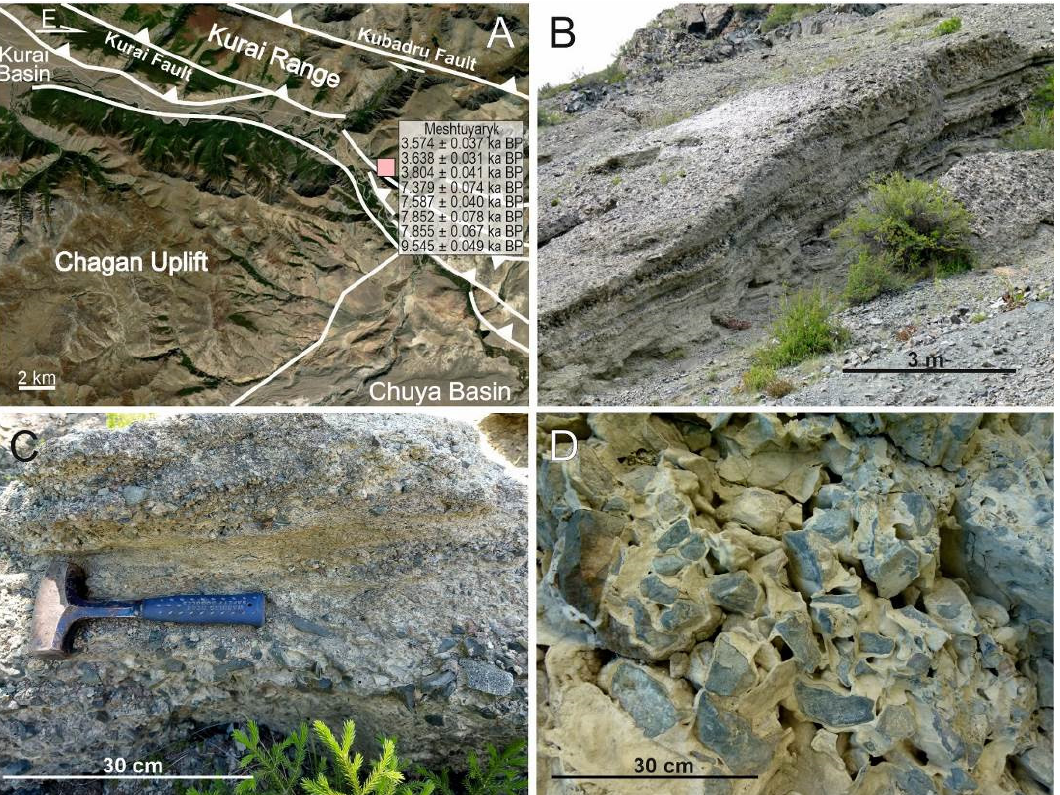
Figure 6. Location and morphology of the Meshtuyaryk travertines. ( A ) Active faults, location, and U-Th dates of the Meshtuyaryk travertines (50.13817° N, 88.34074° E). ( B ) Fragment of a layered breccia body with travertine cement. ( C ) Layered characteristics of travertine-cemented breccia; layering is due to variations in grain sizes of the clastic material. ( D ) Close-up: breccia with travertine cement.